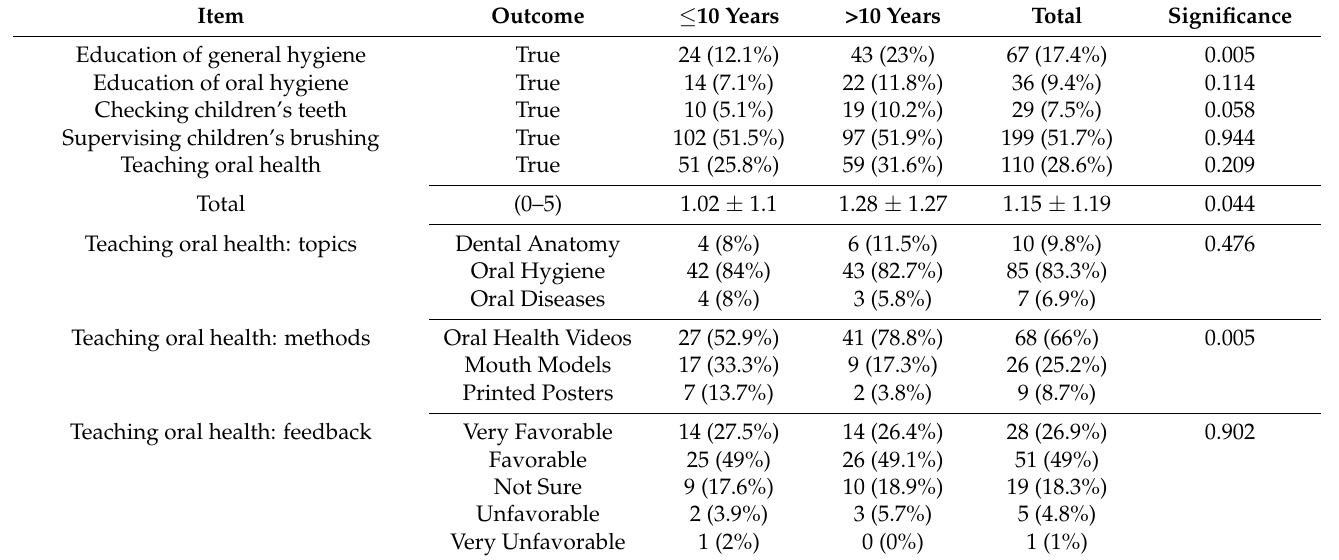
Table 5. Oral health education experience of elementary schoolteachers stratified by work